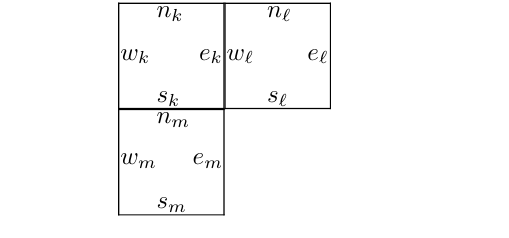
Figure 2. Horizontal, and vertical connectivity among tiles k - ‘ , and k - m ,